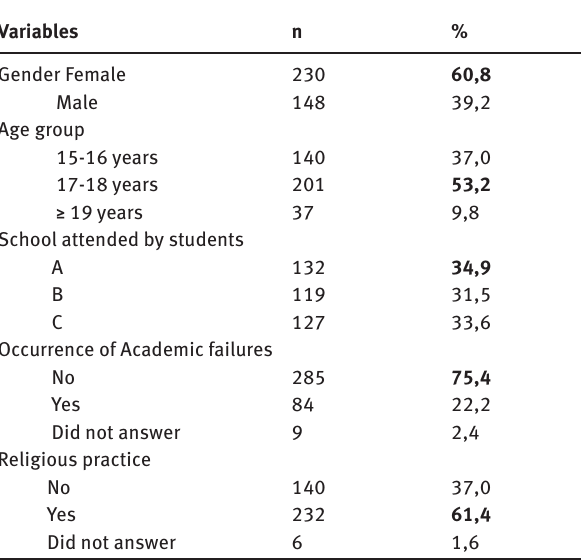
Table 1: Socio-demographic characterization of the sample (%) N =